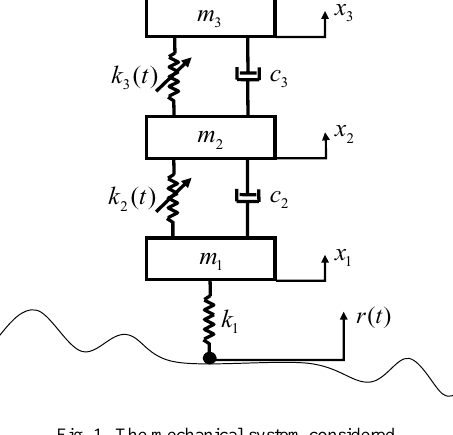
Fig. 1. The mechanical system